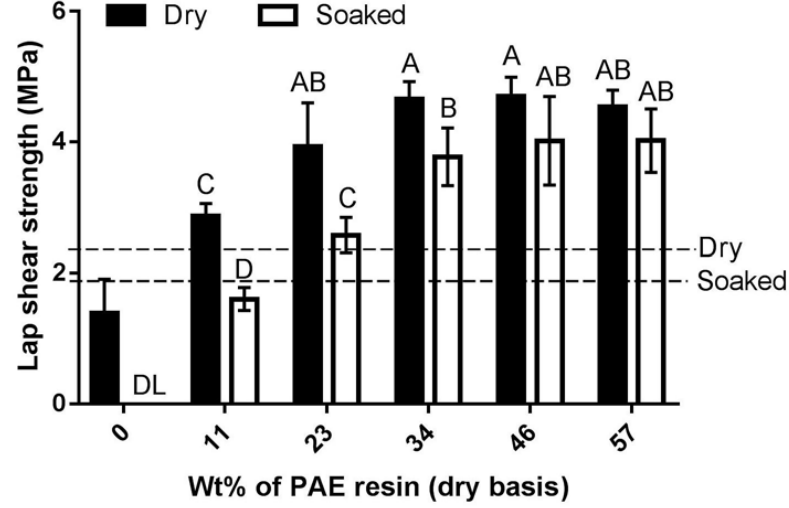
Figure 5. Effect of the weight ratio of peptides and PAE resin on lap shear strength of plywood specimens bonded with the peptides-PAE adhesive. The components of the adhesive system were reacted for 120 min, and the plywood specimens were hot pressed at 120 °C and 3.5 MPa for five minutes. Error bars are the standard deviation of six plywood specimen measurements. Specimens that delaminated when soaked in water are indicated (DL). Means that do not share a letter are significantly different (Tukey, 95% confidence level). The minimum shear strength requirements as specified by ASTM D4690 are shown: 2.344 MPa for dry shear strength; 1.93 M. Figure adopted with copyright permission from MDPI (for Adhikari et al., 2016).